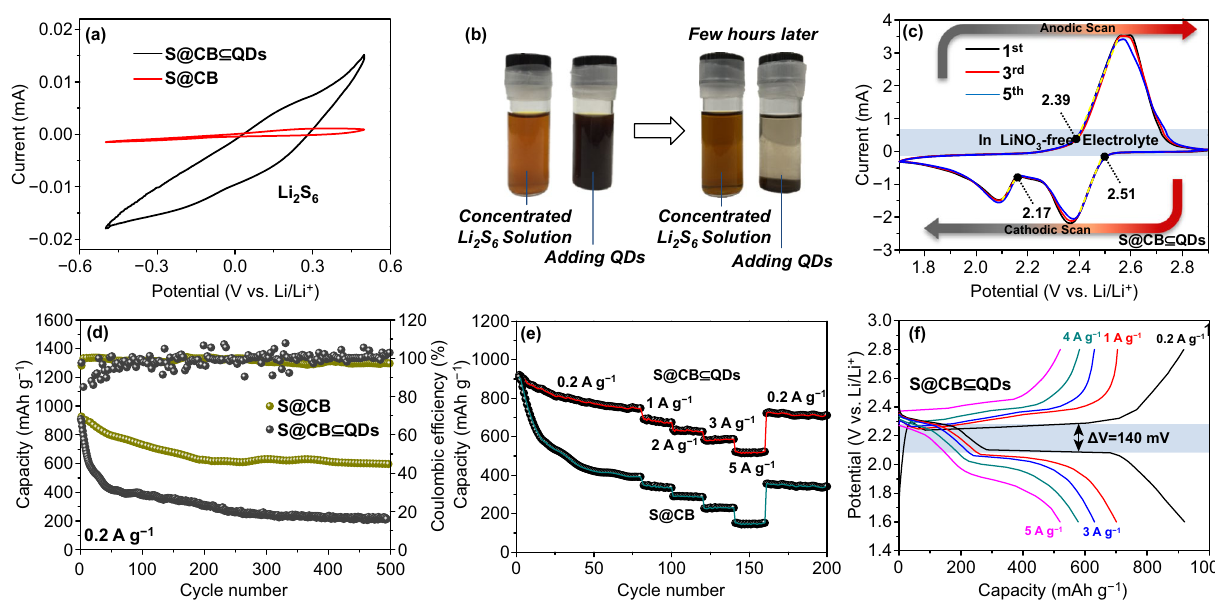
Fig. 4 a CV curve comparisons between QDs-involved and QDs-free cathodes. b Adsorption ability of NiFe 2 O 4 QDs in Li 2 S 6 electrolyte. Elec- trochemical testing results on S@CB ⊆ QDs: c CV curves, d long-term cyclic performance, e rate-varied cyclic record and f rate-varied voltage profiles